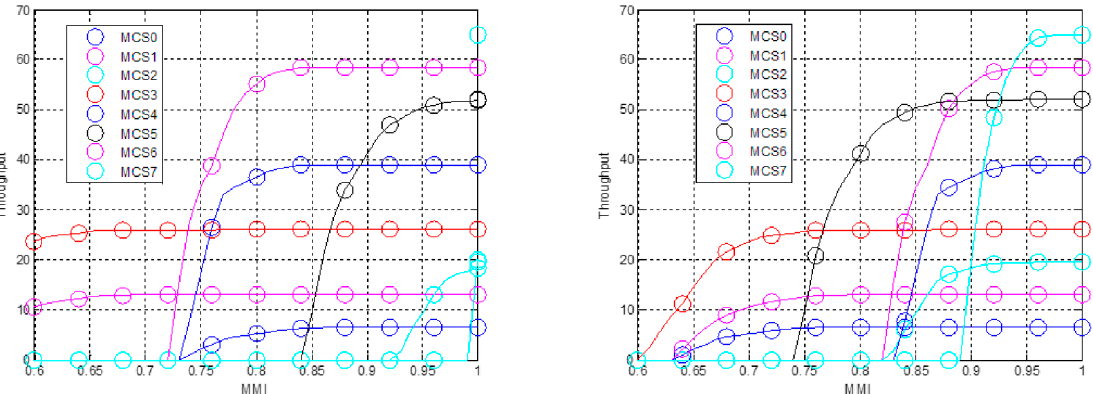
Figure 18. Shifted ( left ) and standard ( right ) MMI-to-throughput tables.